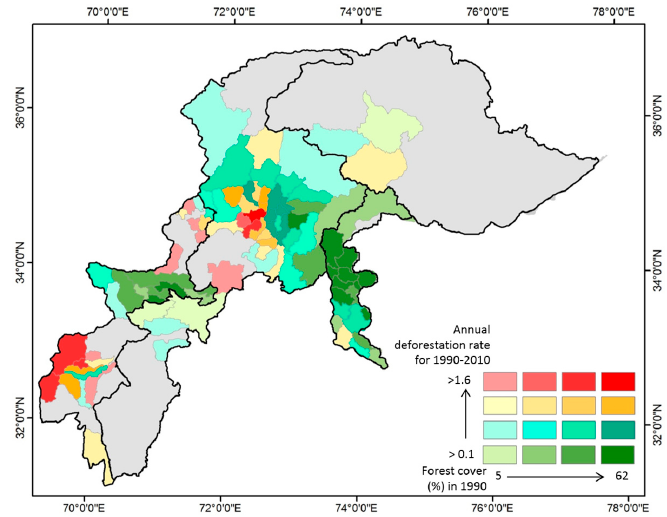
Figure 3. Bivariate map identifying deforestation hotspots by showing forest cover and deforestation rate for Tehsils (sub-districts) having more than 5% forest cover in 1990.